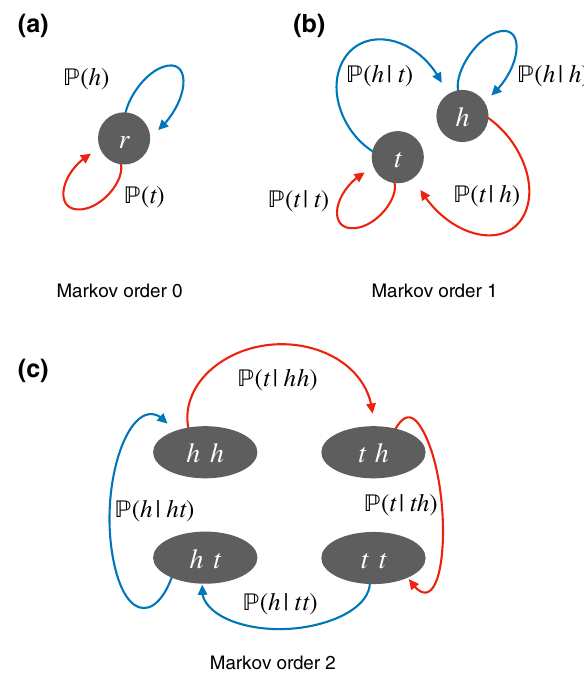
FIG. 4. Markov chains. Given a time series of coin flips we can deduce any of the above hidden Markov models. At memory length 2 we have a deterministic process and therefore longer memory will not yield any more information. In other words, the Markov order of the process in (c) is